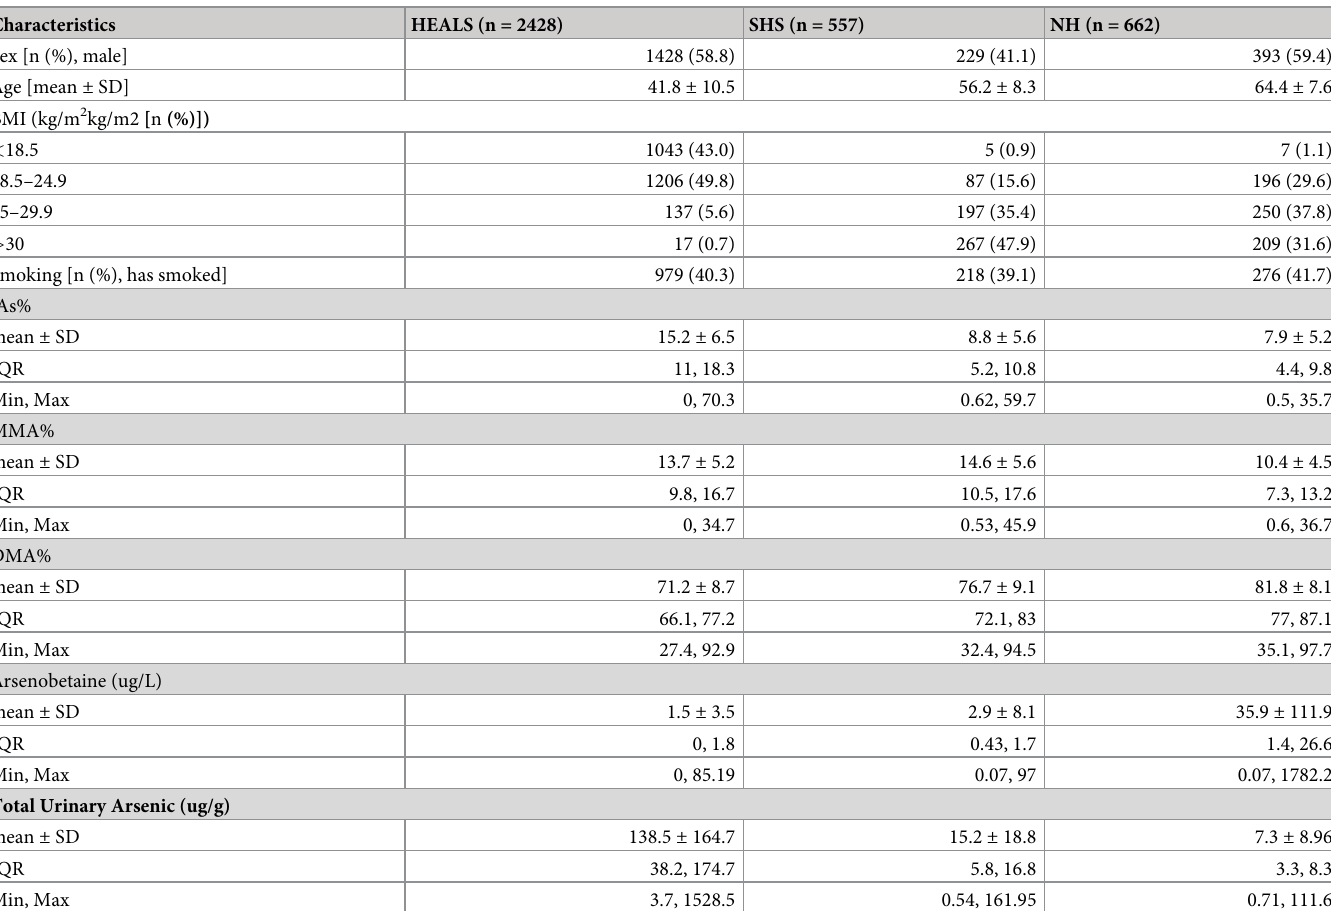
Table 1. Participant characteristics and arsenic species concentrations stratified by cohort.